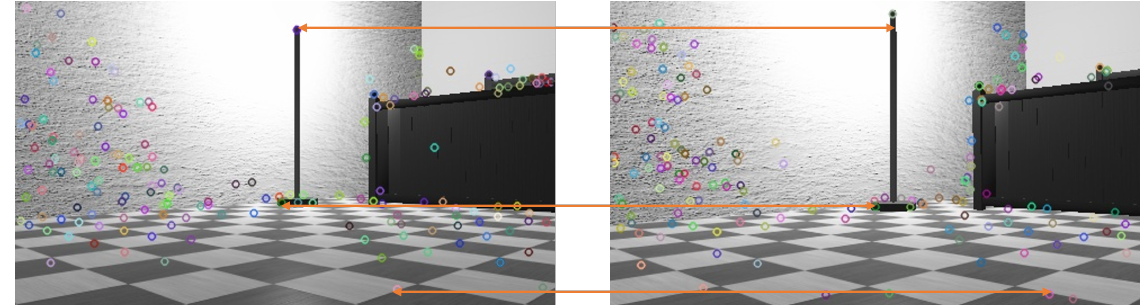
Figure 18. Figure showing the feature matching to determine local